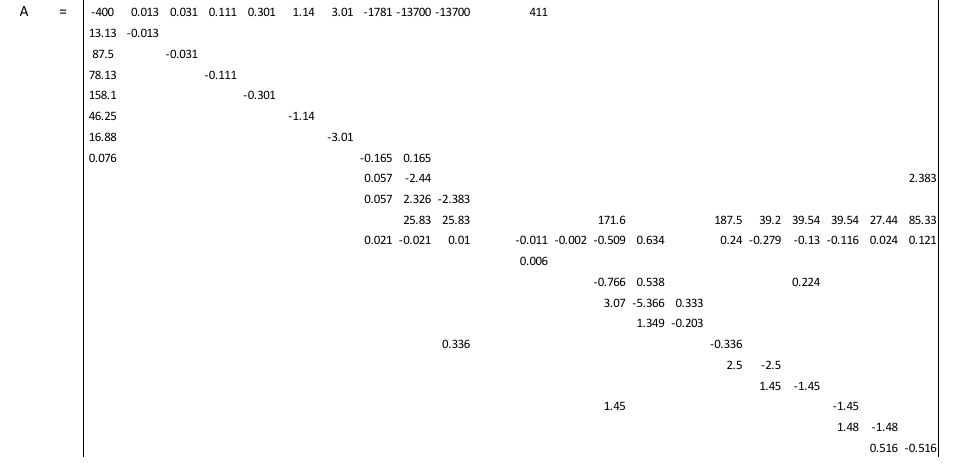
Figure 12. Matrix A for State = Space system.